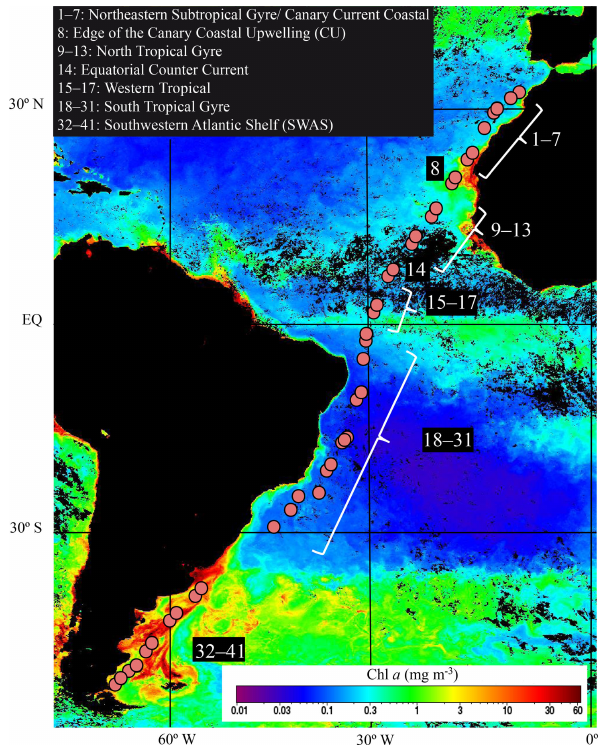
Figure 1. Hydrographic stations (filled circles) of the TransPE- GASO cruise, sampled during October–November 2014 in the At- lantic Ocean. Chl a concentration (background color; mgm − 3 ) val- ues during November 2014 were taken from a NASA MODIS Aqua 9km product